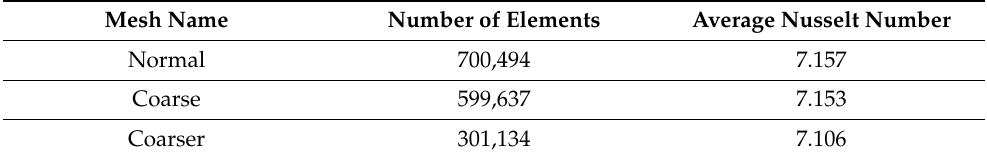
Table 1. Mesh sensitivity